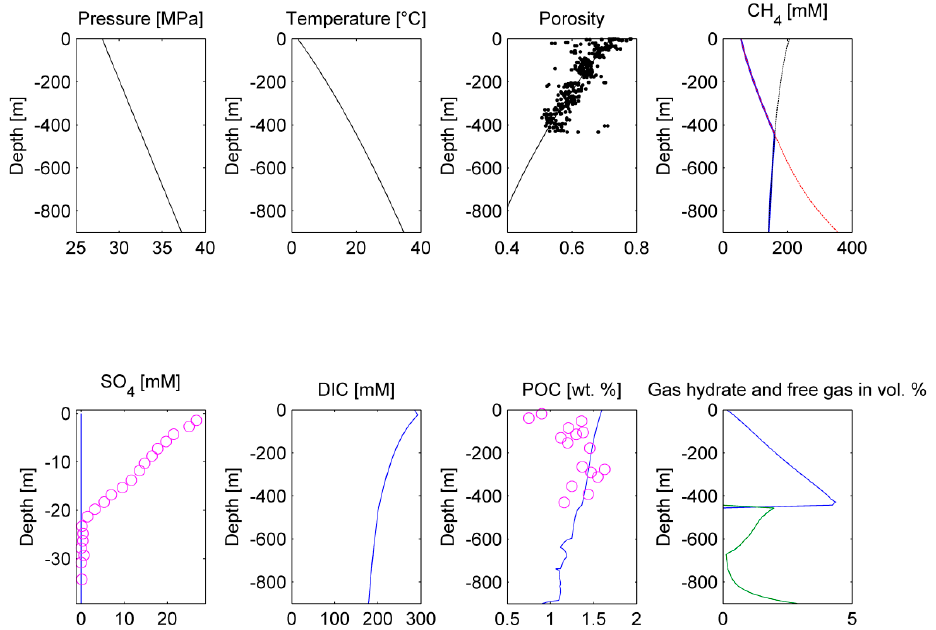
Figure 8. Modeling results of the Scenario 4. Upper panel, from the left: Pressure, temperature, porosity, and dissolved CH 4 concentration plots. Porosity measurements [20] are depicted as black dots, the modeling solution is represented by the black line. On the CH 4 concentration plot, red line depicts the phase boundary between gas hydrate and dissolved methane, black line represents the phase boundary between free gas and dissolved methane, blue line states dissolved methane concentration. Gas hydrate and / or free gas formation occurs wherever dissolved methane concentration exceeds one of the solubility curves. Lower panel, from the left: SO 4 , DIC, POC, and gas hydrate / free gas concentration plots (in blue and green, respectively). On the SO 4 and POC concentration plot, measured values are presented as pink circles [20], whereas model predictions are shown as the blue lines.